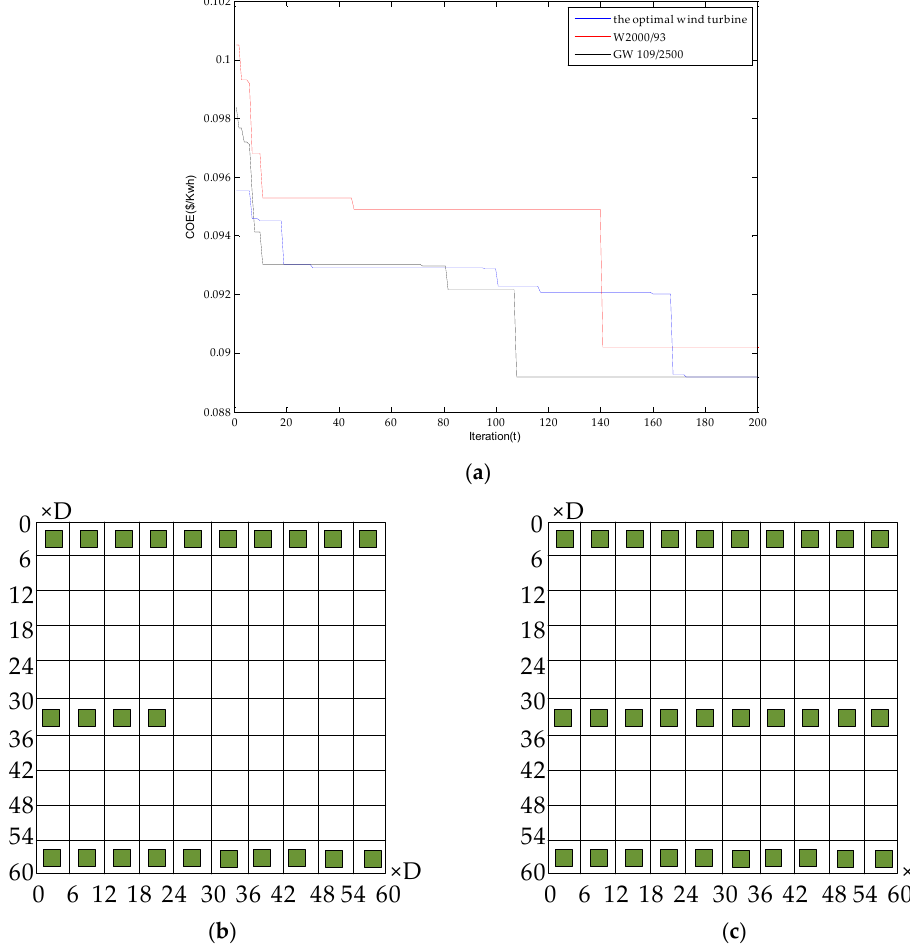
Figure 7. The results of the objective function (COE) and optimal layout: ( a ) results of objective function, ( b ) optimal layout of GW109/2500, and ( c ) optimal layout of W2000/93. Case 3: The n R land φ offshore wind farm, Denmark, is located at latitude 56.662 and longitude 8.221 .